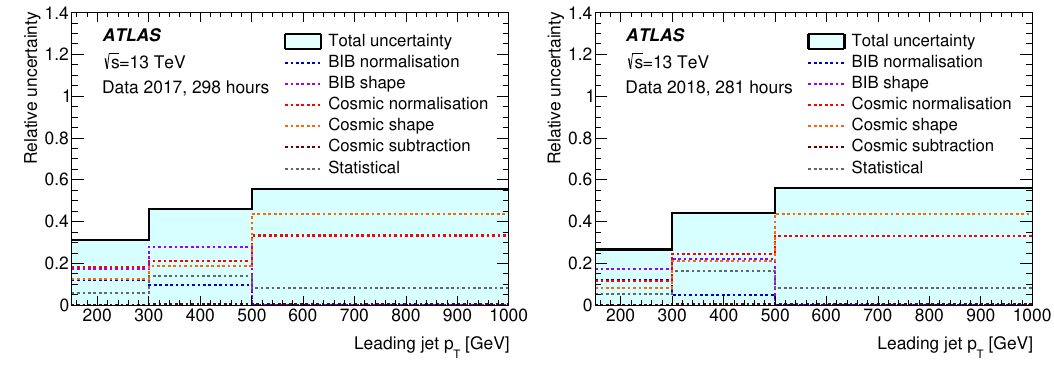
Figure 7 . Summary of the relative uncertainties in the total expected background prediction in each jet p bin of SRC for 2017 (left) and 2018 (right) T